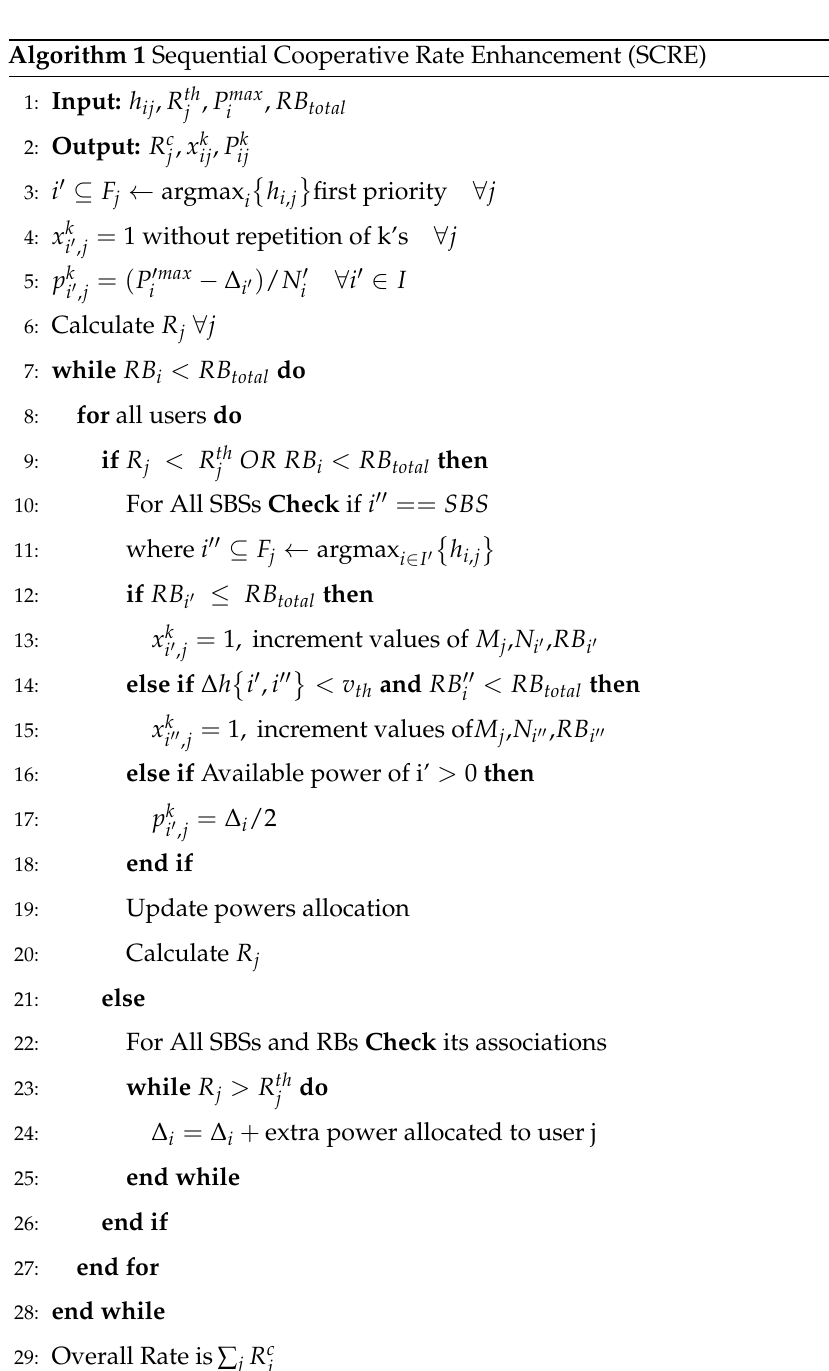
Algorithm 1 Sequential Cooperative Rate Enhancement